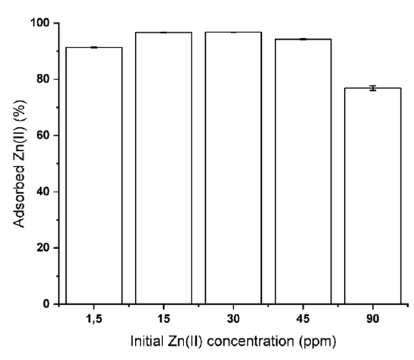
Figure 2. Cellulose-based nanosponges’ (CNS) adsorption efficiency of Zn(II) from mono-contaminated artificial seawater (ASW) at different ion concentrations. CNS amount: 0.8 g L − 1 .